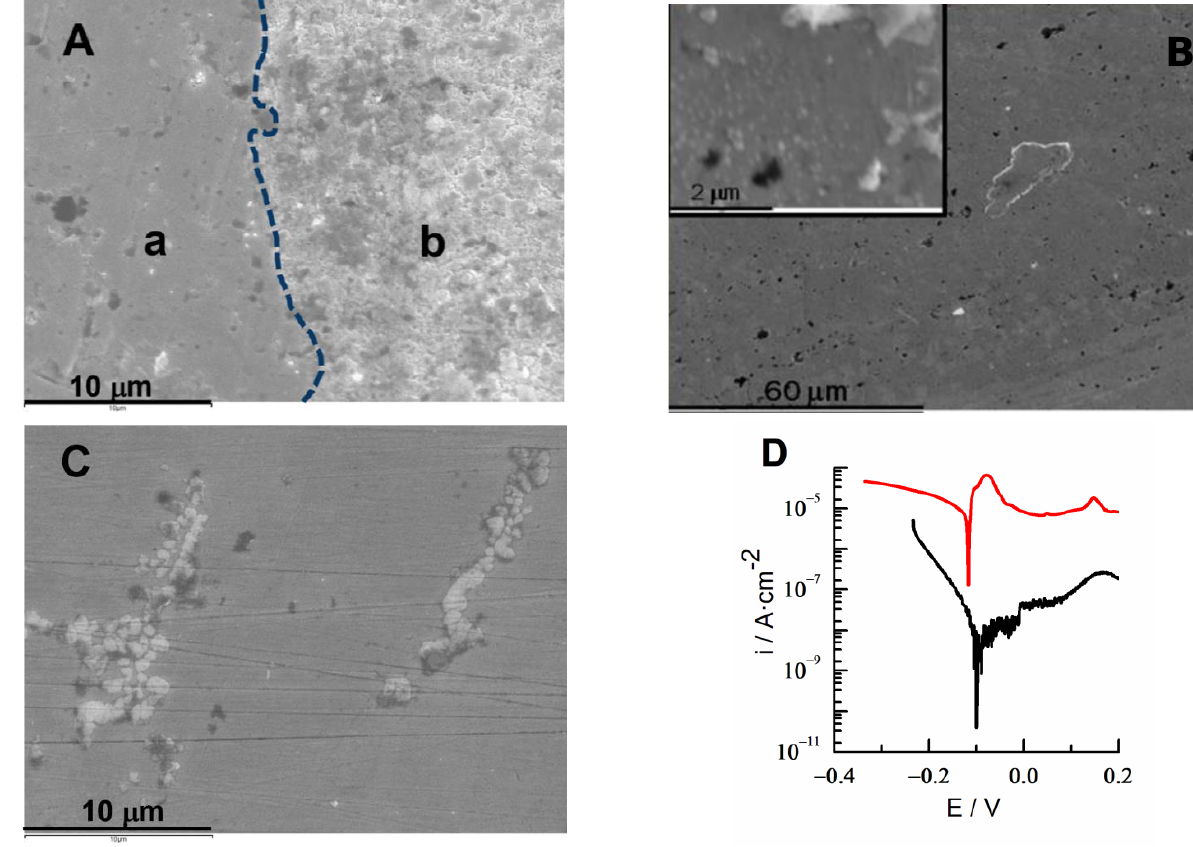
Figure 4. SEM micrographics of an Au 18K gold alloy after anodic polarization in 3.5% NaCl. ( A ) High polarization potential where the unexposed ( a ) and exposed ( b ) corrosion wire areas are shown. ( B ) Intermediate polarization potential with barely appreciable corrosion. Inset: zoom in image. ( C ) Effect of three successive polarization scans up to potential of a plate. ( D ) Comparative polarization curves of wire (red) and plate (black).